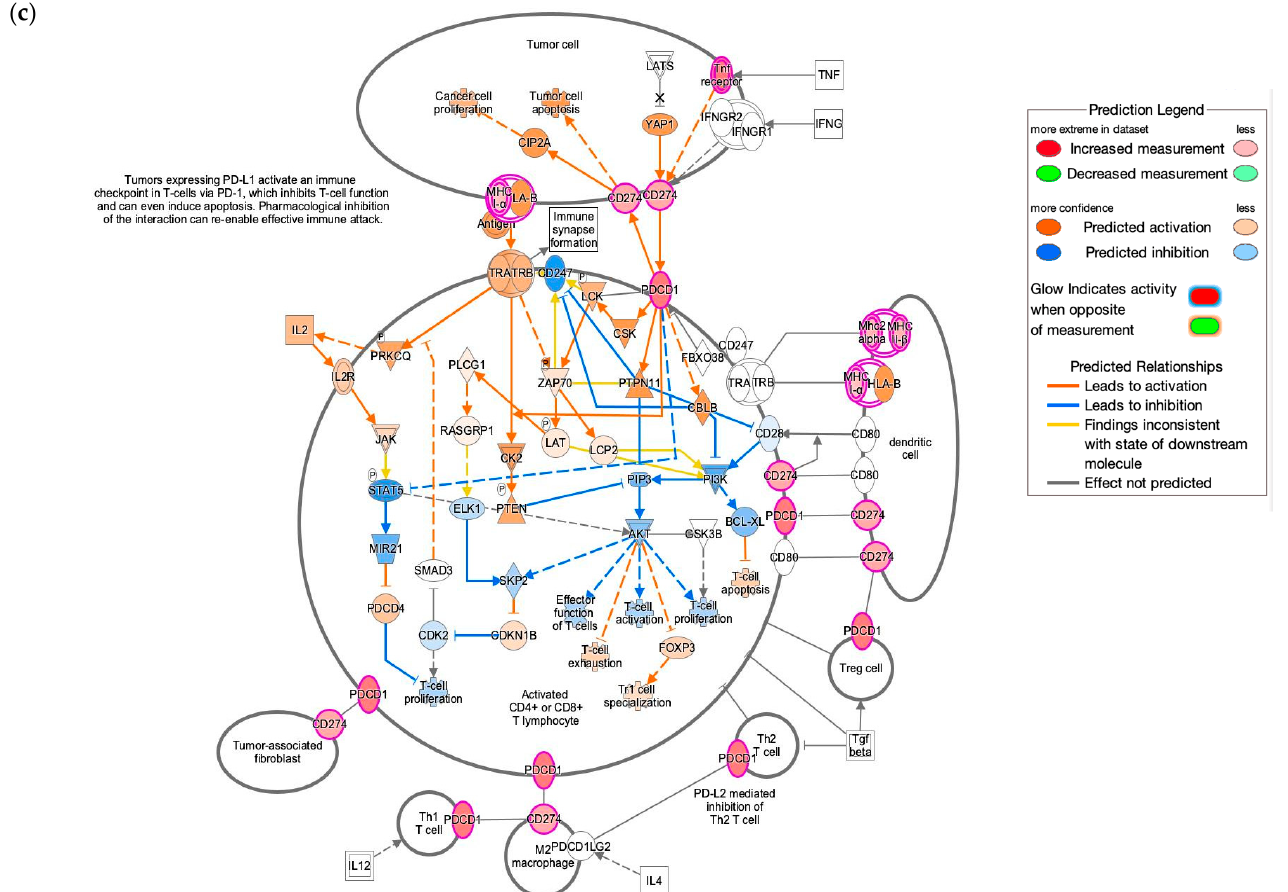
Figure 5. Specific immunological perturbation associated with the ceRNA network. ( a ) Influence network showing the activation or inhibition of the key molecules and pathways defined by the ceRNAs. ( b ) Pathways enriched and influenced by the ceRNA dysregulation according to response to ICB. ( c ) Activated and inhibited genes and pathways of the PD1–PDL1 axis in the context of ceRNA dysregulation.